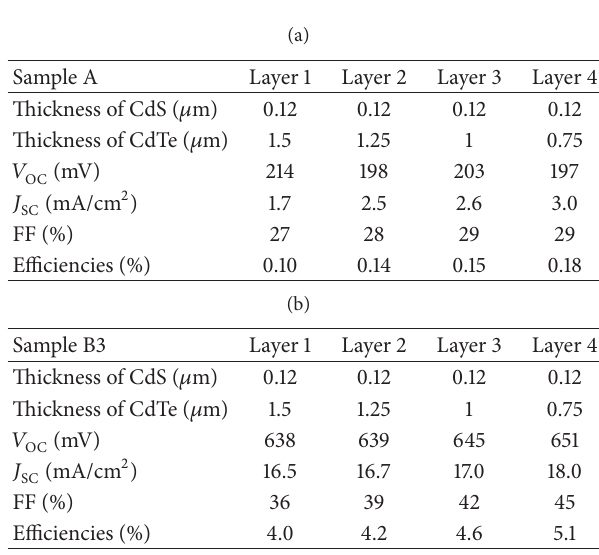
Table 1: (a) Thicknesses and electrical properties of sample A without CdCl 2 annealing. (b) Thicknesses and electrical properties of sample B3 with 15min. CdCl 2 annealing.